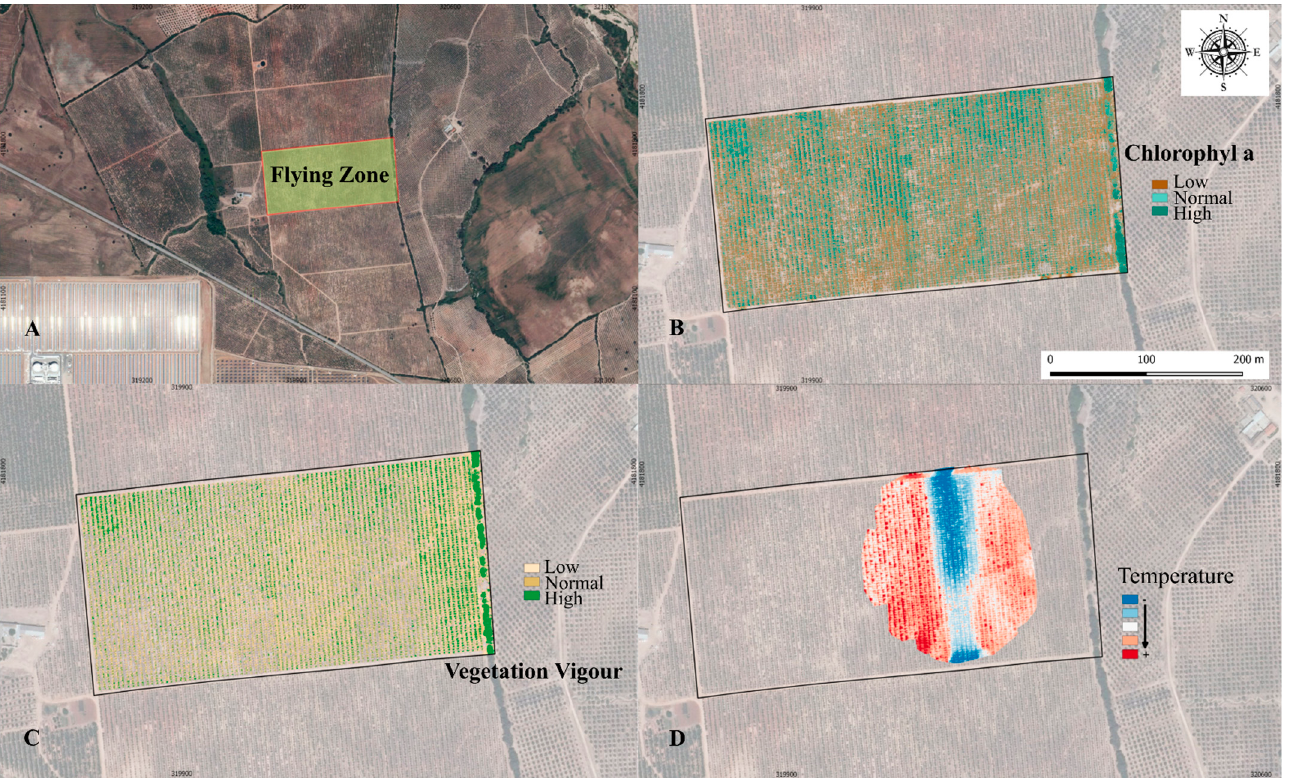
Figure 6. Vegetation index (VIs) maps generated through Parrot Sequoia (a multispectral camera) and Yuneec CGOET (a thermal sensor) mounted on Yuneec Typhoon H hexacopter RPA. ( A ) Crop area studied. ( B ) Map of “chlorophyll a” content based on NDRE. ( C ) Map for vegetation status generated based on NDVI. ( D ) Thermal map established using Yuneec CGOET. (Images facilitated by MCBiodrone).